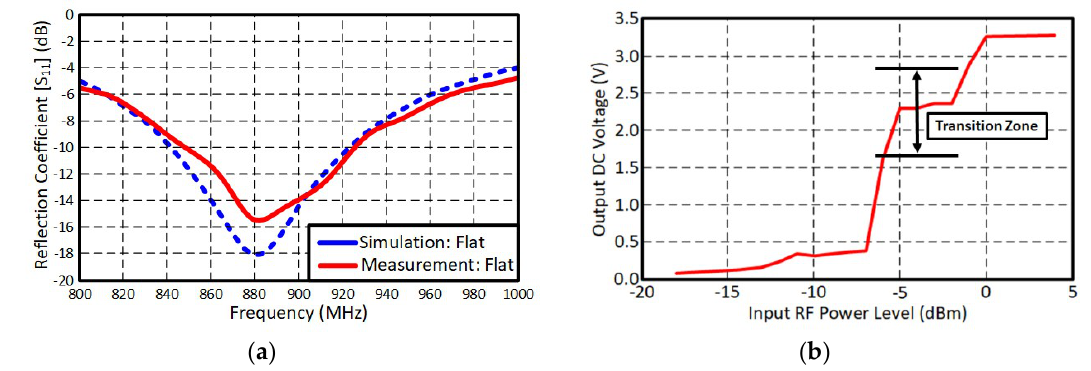
Figure 7. Measurement results. ( a ) The loop antenna and ( b ) RF-DC